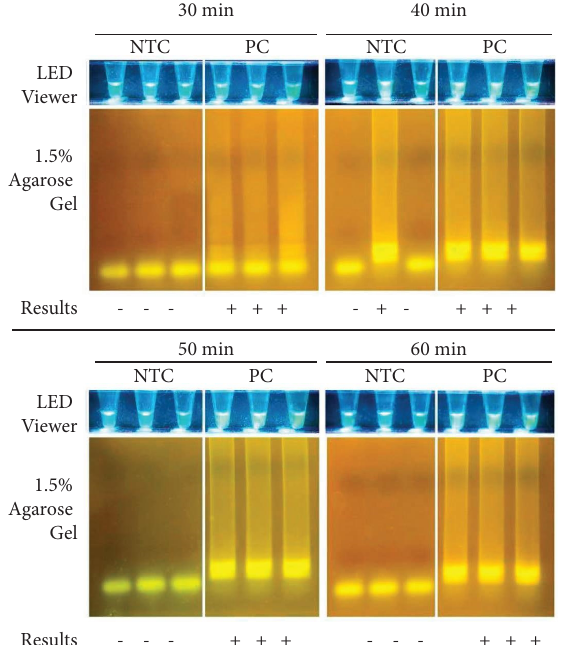
Figure 6: Optimization of assay incubation time. Sample (2.5 μ L) was added to 10 μ L reagent mix then incubated at 65 ° C for 30–60